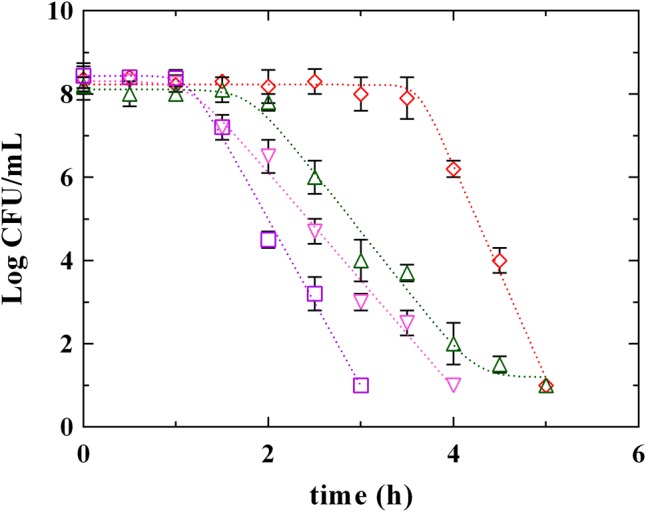
Survival of L. innocua ATCC 33090 in MES buffer containing: (□), gallic acid (GA_MBC); (△), ferulic acid (FA_MBC); (▽), caffeic acid (CA_MBC) or (♢), phenyllactic acid (PLA_MBC) at MBC concentration detected at pH 5.5. Symbols represent the mean values with standard deviation of three independent experiments and the curves represent the survival models obtained with GInaFiT software.